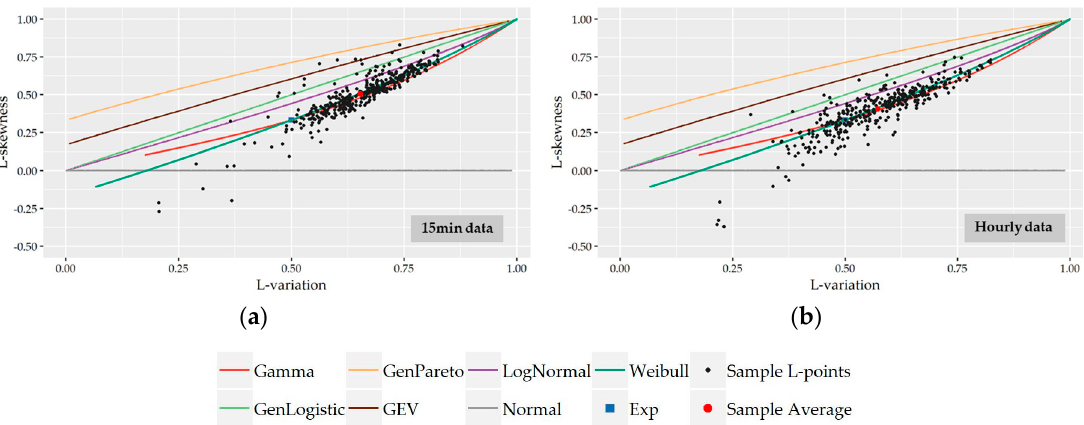
Figure 6. L-variation vs. L-skewness ratio diagrams that compare the observed L-points of the nonzero 15-minute ( a ) and hourly ( b ) water demand records of all households per hour against the theoretical L-points of the distributions under investigation.